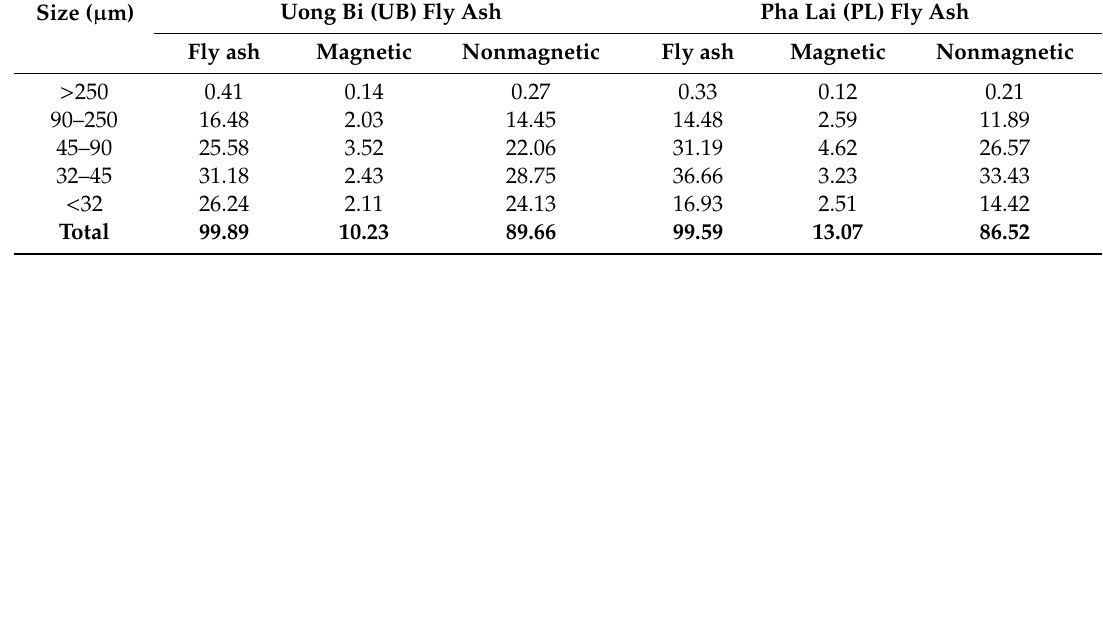
Table 2. Magnetic and nonmagnetic contents in di ff erent size fractions of UB and PL fly ashes. Size ( µ m)